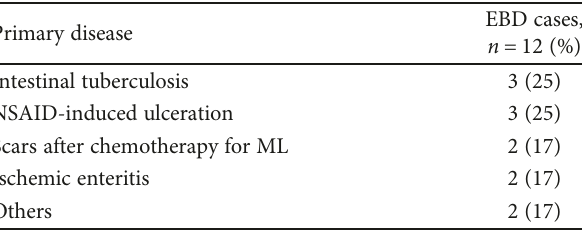
NSAID: nonsteroidal anti-in fl ammatory drug; ML: malignant